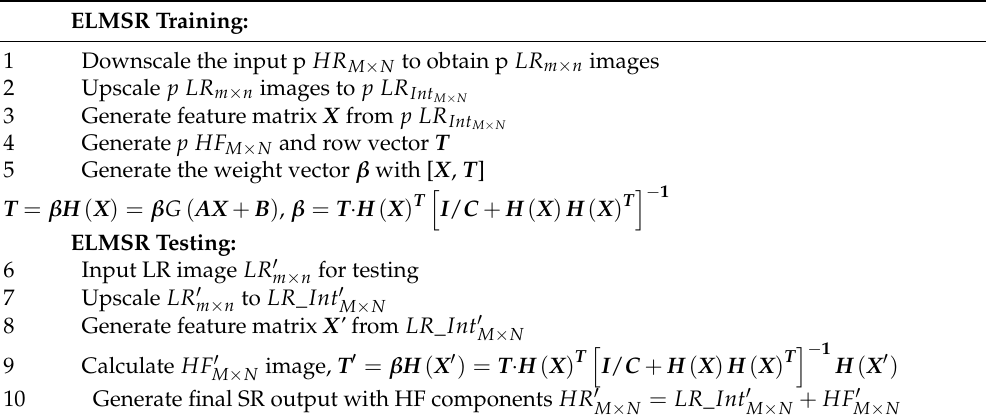
Table 2. Pseudo code for extreme learning machine based super-resolution